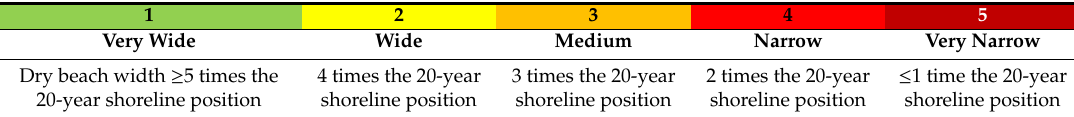
Table 2. Bu ff er zone classes expressed according to the dry beach width and the 20-year predicted shoreline position the color scale indicates the intensity of exposure i.e. a large bu ff er zone shows a low exposure.